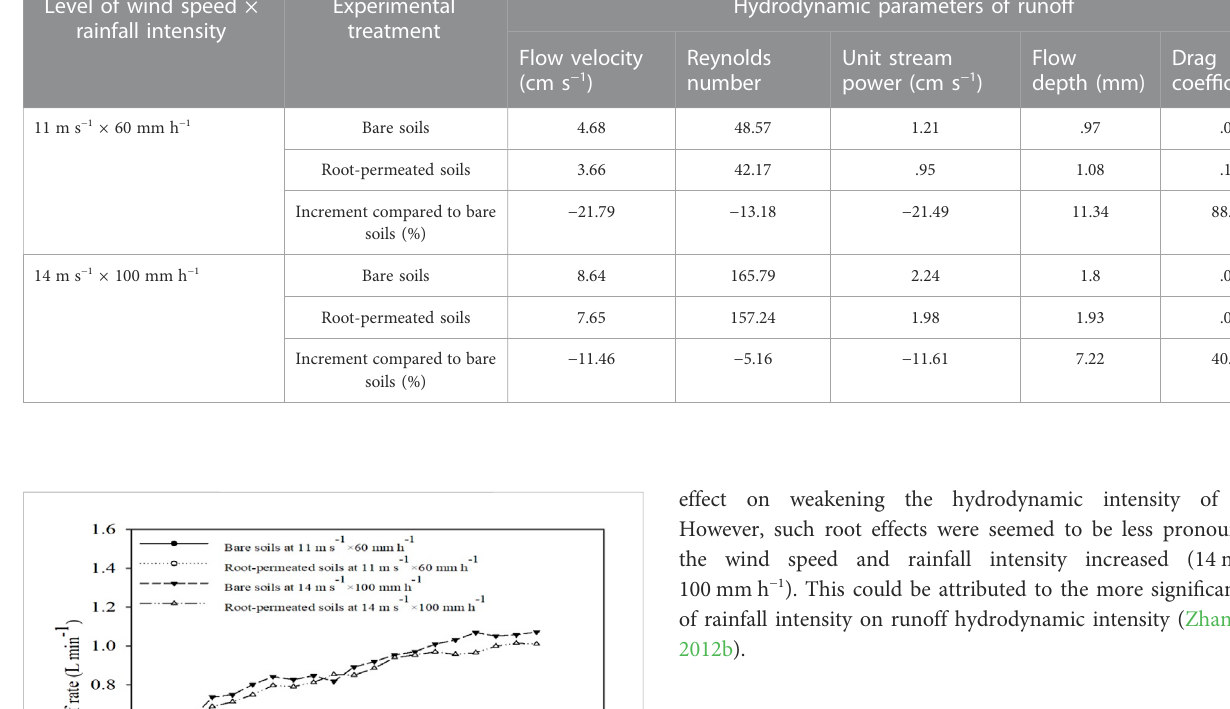
TABLE 4 Hydrodynamic parameters of runoff for bare and root-permeated soils in simulated rainfall following wind tunnel tests. Level of wind speed × rainfall intensity